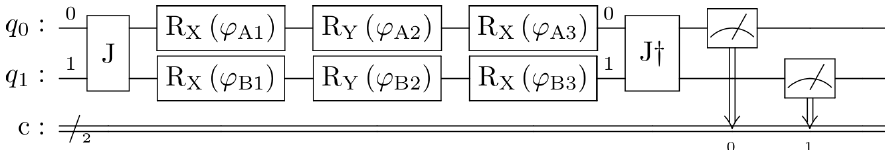
Figure 2. EWL game model for 2 players with rotation